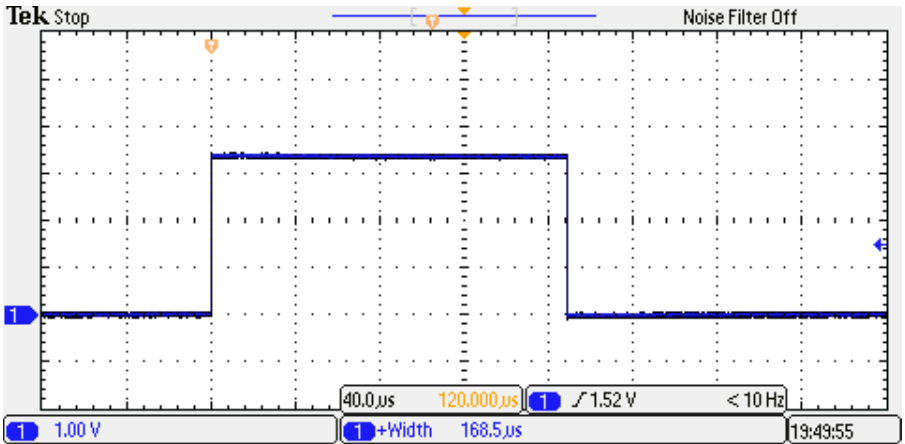
Figure 8. Measurement of the processing time of the kernel with the proposed accumulator implemented on the FPGA. Sensors 2020 , 20 , x 15 of 18